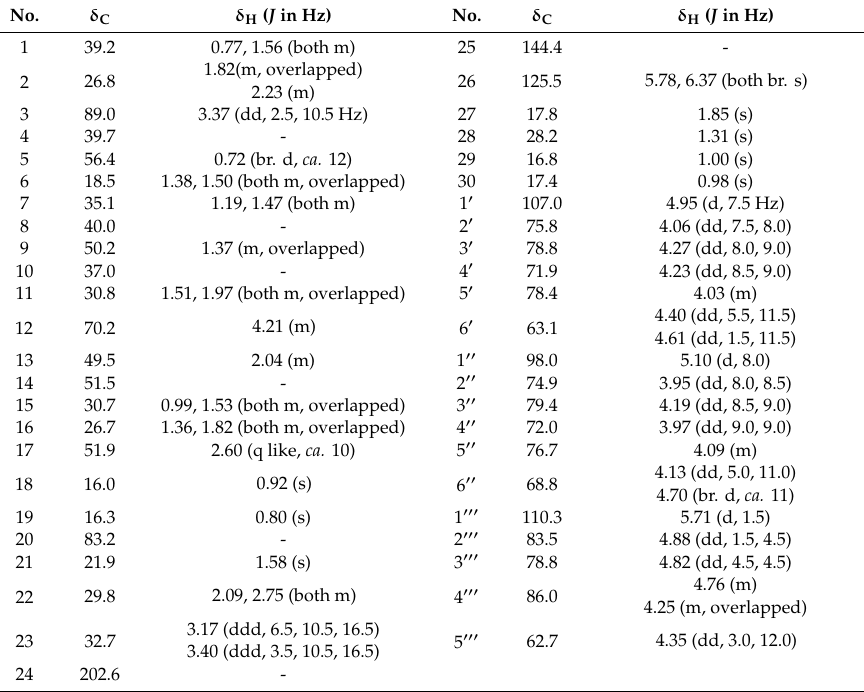
Table 8. The 1 H and 13 C-NMR data for 8 in C 5 D 5